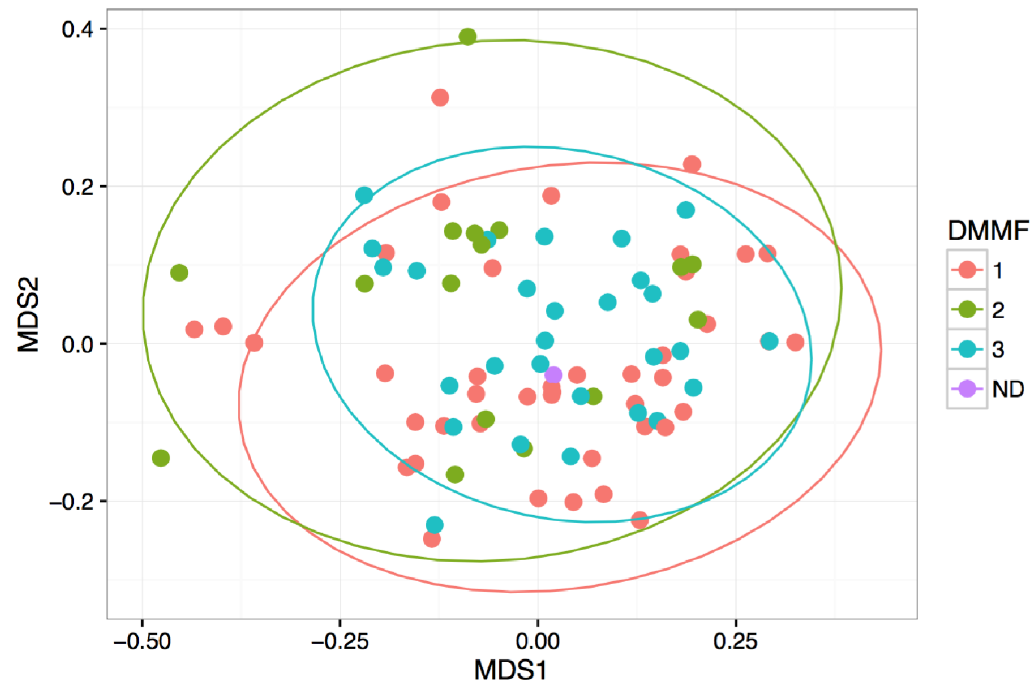
Fig 2. Non-metric multidimensional scaling (NMDS) ordination plot. The NMDS is based on Bray-Curtis dissimilarities between OTU-level microbiota communities in three groups: 1 = DM-, 2 = DM+/MF-, 3 = DM+/MF+, ND = not defined. Pairwise ANOSIM comparison showed a trend for DM+/MF- vs. DM+/MF+ (p = 0.067). Abbreviations: DM = type 2 diabetes mellitus, MF = Metformin.